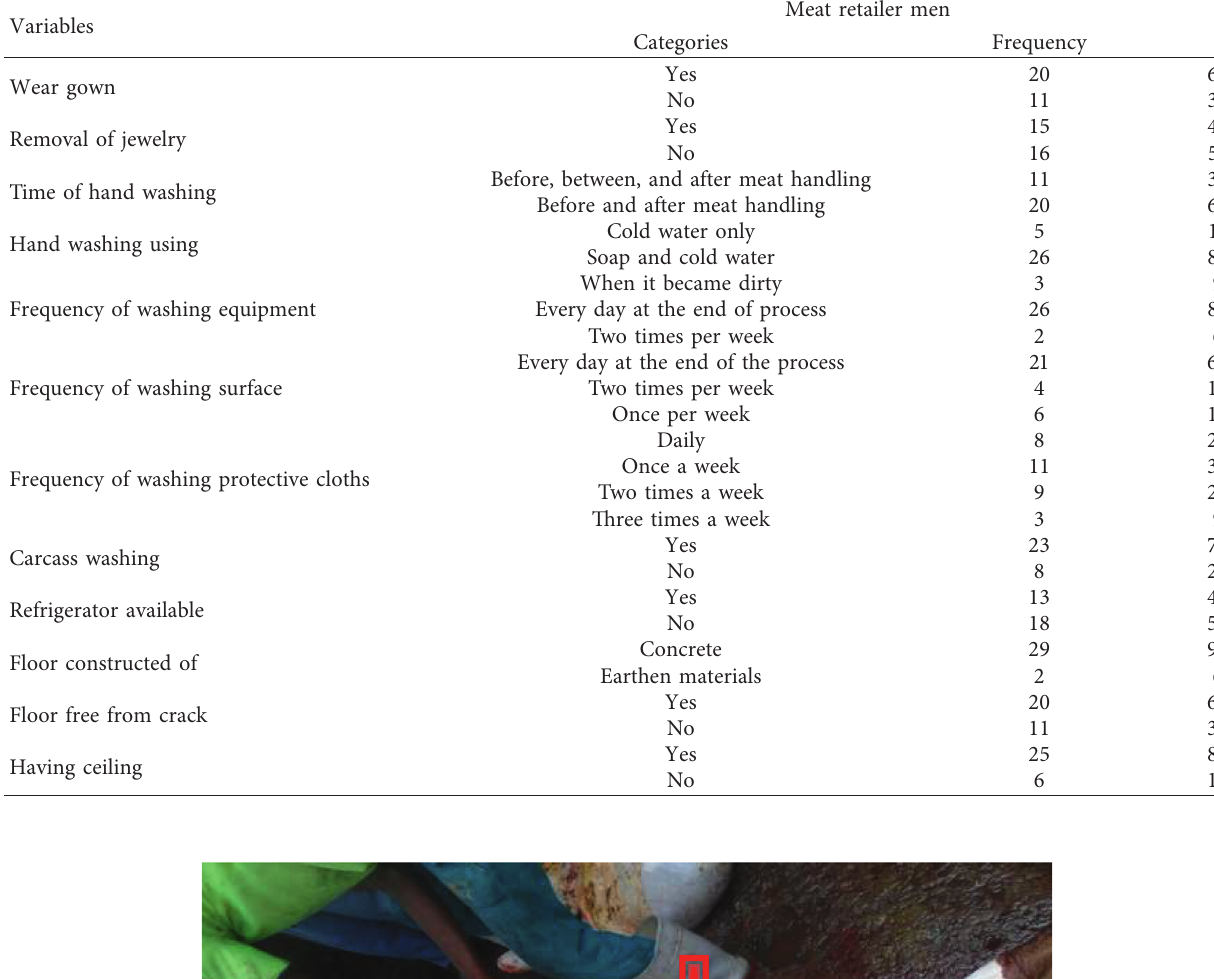
Table 4: Personal hygiene and sanitation of retailers regarding meat safety in Ambo, West Shewa, Ethiopia (January 2016 to May 2017). Variables